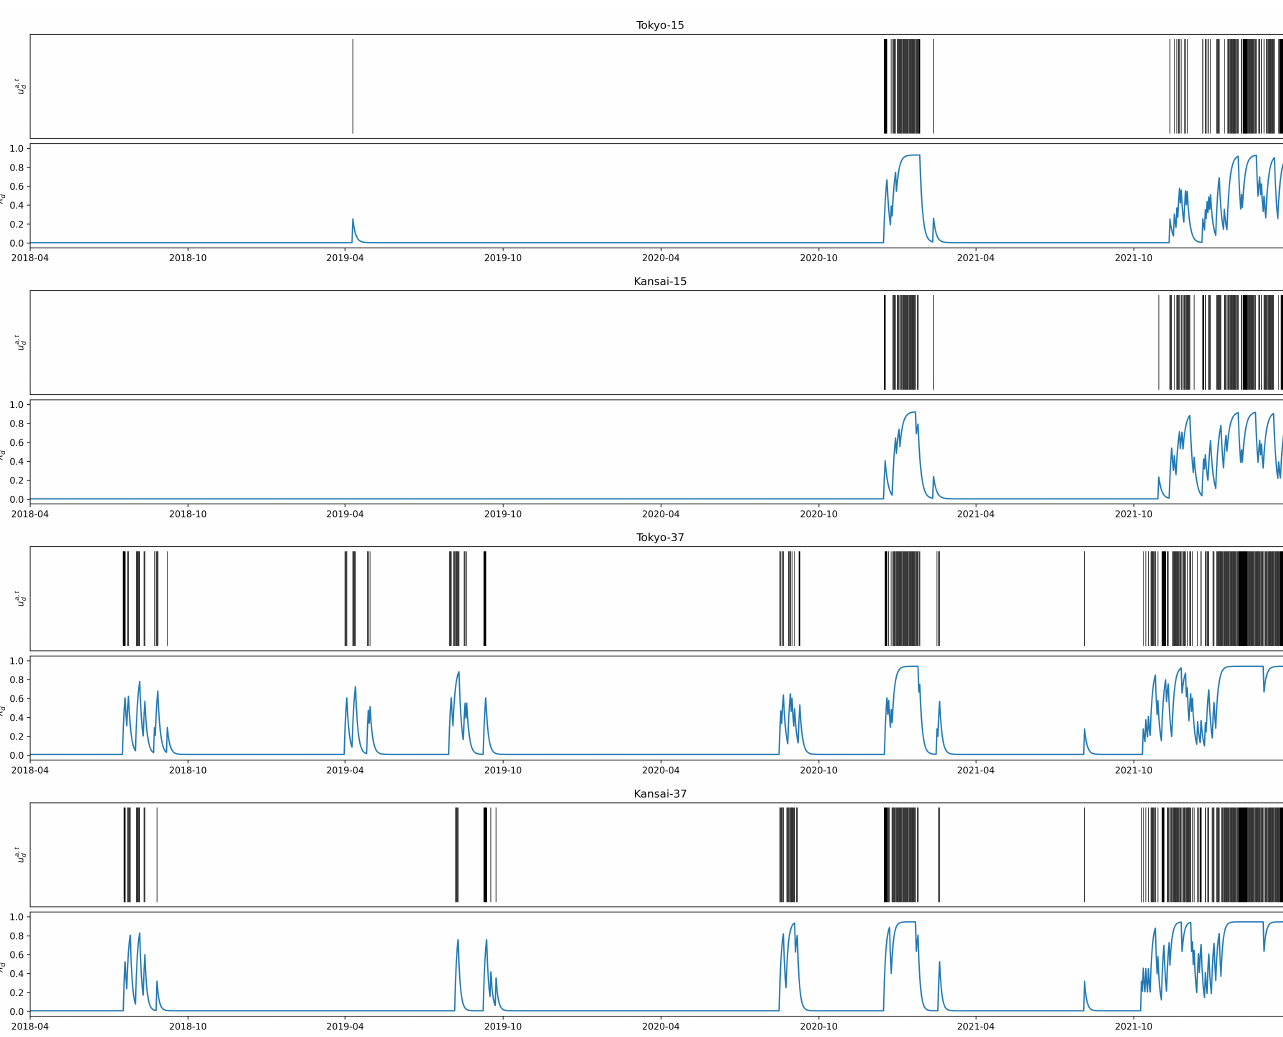
for the four selected area–time-code d